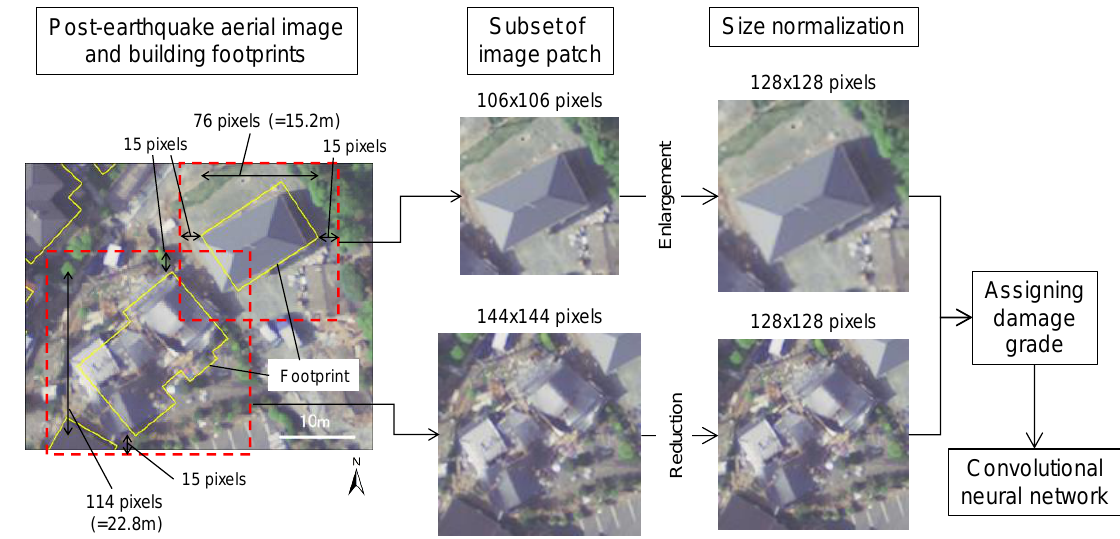
Figure 5. Flow for the preprocessing of the image patches extracted from the aerial image.